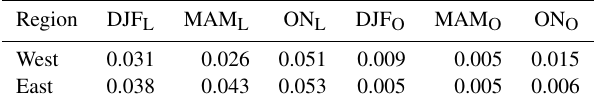
Table 2. Difference between OMI SSA and cSSA. Subscripts L and O denote land and ocean respectively. Region DJF L MAM L ON L DJF O MAM O ON O West 0.031 0.026 0.051 0.009 0.005 0.015 East 0.038 0.043 0.053 0.005 0.005 0.006